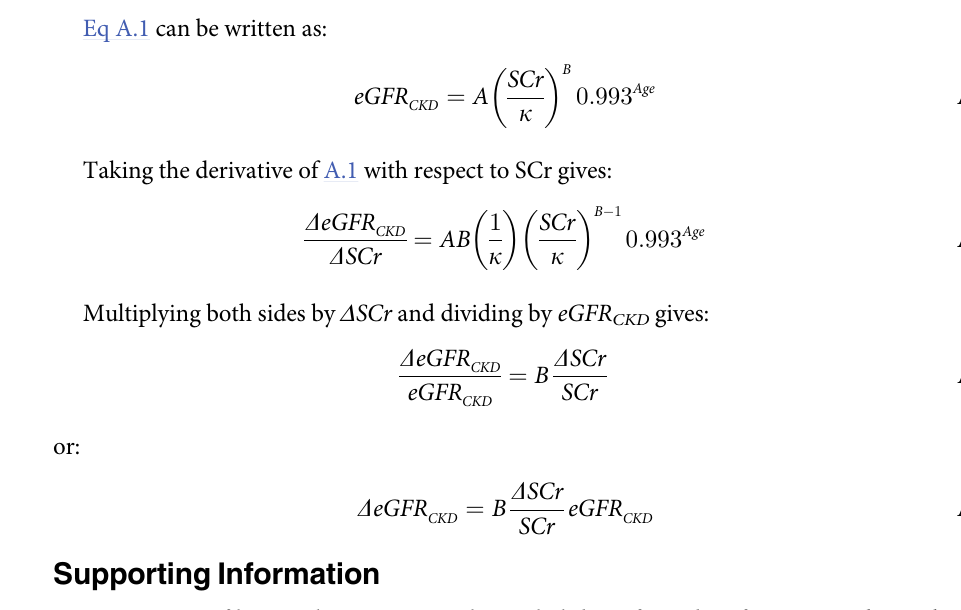
S1 Fig. Impact of bias and precision on the probability of misclassification. Each panel shows the distribution of measurements centered on the true value. The width of the distribu- tion depends on the variation of the measurement. The decision limit is 60 for all three cases. The shaded area indicates probability of misclassification given the distance between the true value and decision limit and the precision. S2 Fig. Impact of the eGFR distribution on misclassification. The graph shows the eGFR dis- tribution for two different hypothetical patient populations. The upper panel represents a rela- tively healthy population in which the majority of eGFR values are greater than 60 ml/min/ 1.73 m 2 . In this population, the misclassification rate will be greatest at 60 ml/min/1.73 m 2 . The lower panel represents a specialized population with kidney disease. In this population, the misclassification rate will be greatest at 30 ml/min/1.73 m 2 . S3 Fig. Impact of bias on misclassification. The true result is indicated by a lower case x and the biased value is indicated by an upper case X. The decision limit is indicated by L. Due to imprecision, the observed values will form a distribution around the mean value. In the upper panel, bias moves the mean toward the decision limit and increases the probability of misclassi- fication. In the lower panel, bias moves the mean away from the decision limit and decreases the probability of misclassification. S4 Fig. Limits of biological variation as a function of eGFR. The lower limit is the 2.5 th per- centile and the upper limit is the 97.5 th percentile of observations. S5 Fig. Comparison of observed discordances to biological variation. Each line represents the difference between the Jaffe result and enzymatic result. The vertical lines indicate the deci- sion limit and two standard deviations of the difference (Jaffe-enzymatic) due to measurement imprecision at the decision limit. The arrows are directed from the enzymatic result toward the Jaffe result (the Jaffe result is greater than enzymatic when arrows point from left to right). Heavy lines indicate statistically significant discordances (i.e., greater than two